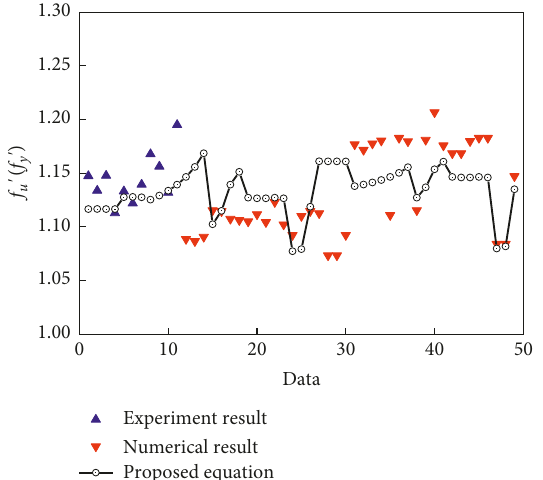
Figure 26: Comparison results by equation (2) and test and